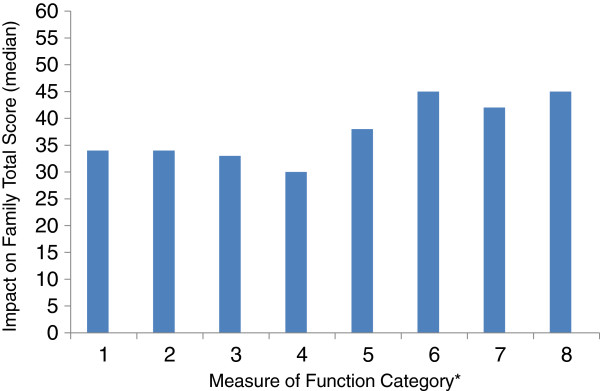
Distribution of the Impact on Family Score by MOF* level of function scores. * MOF Score definitions: 1- Superior functioning. 2- Good in all areas. 3- No more than slight problems. 4- Some difficulty in a single area. 5- Variable problems in some areas. 6- Severe problems in one area or moderate problems in most areas. 7- Major problems in several areas. 8- Unable to function in most areas. 9- Needs nursing supervision. 10- Needs constant supervision.